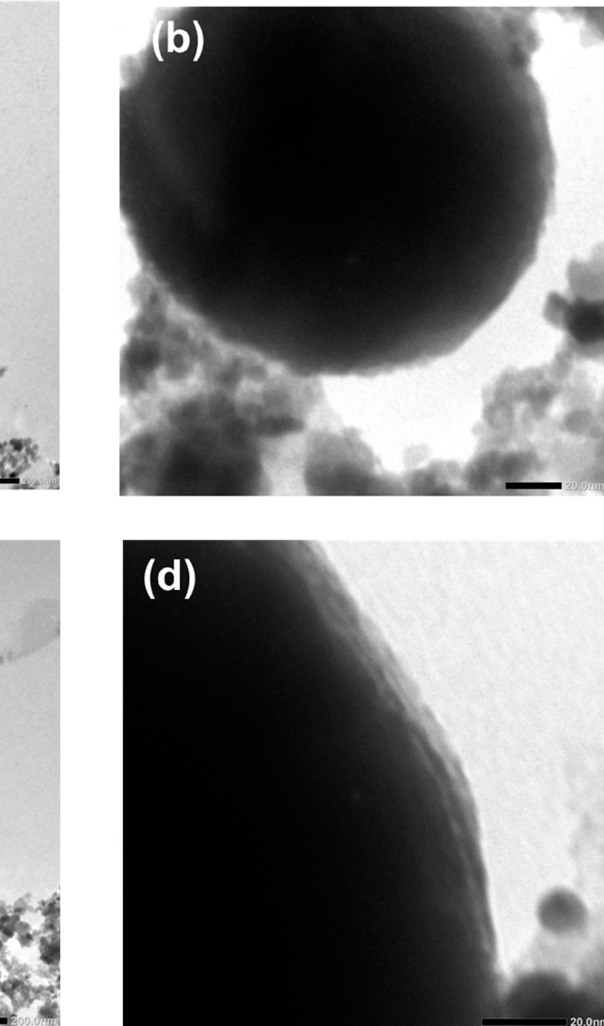
Figure 9. TEM images of ( a , b ) pure and ( c , d ) Pt-doped ZnO nanoparticles.